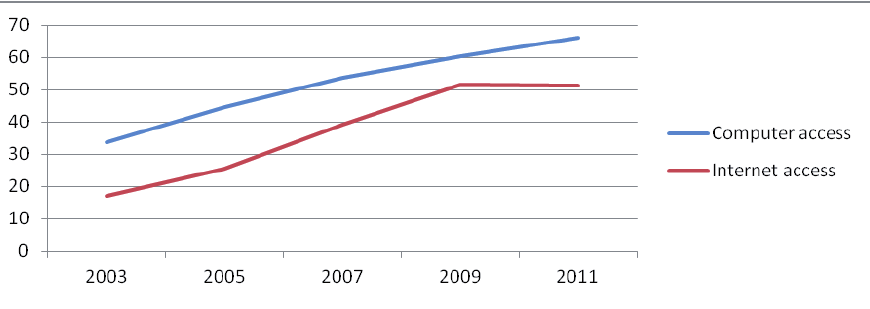
Figure 2. Household computer and Internet access in Poland in years 2003 - 2011 (% data) Source: Batorski, 2011, p.